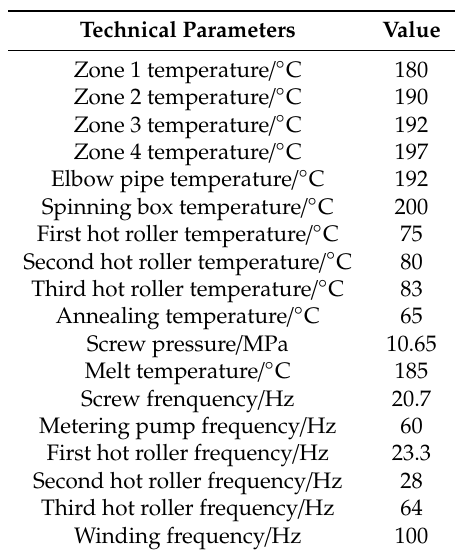
Table 2. The spinning technical